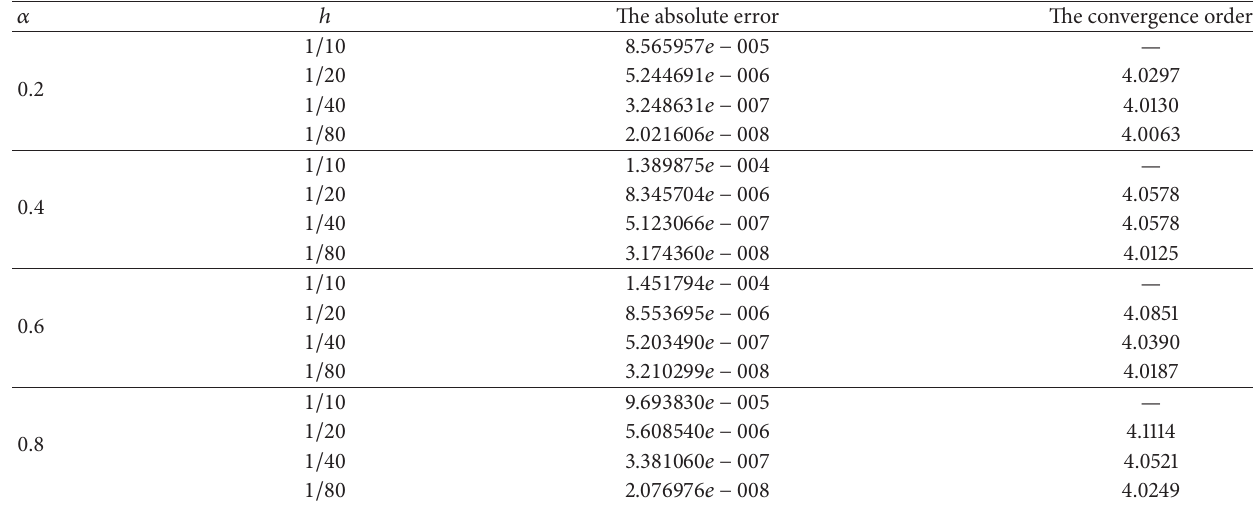
Table 2: The numerical results of the Example 8 with 𝑞 = 4 by formula (14) with 𝑝 = 4 .